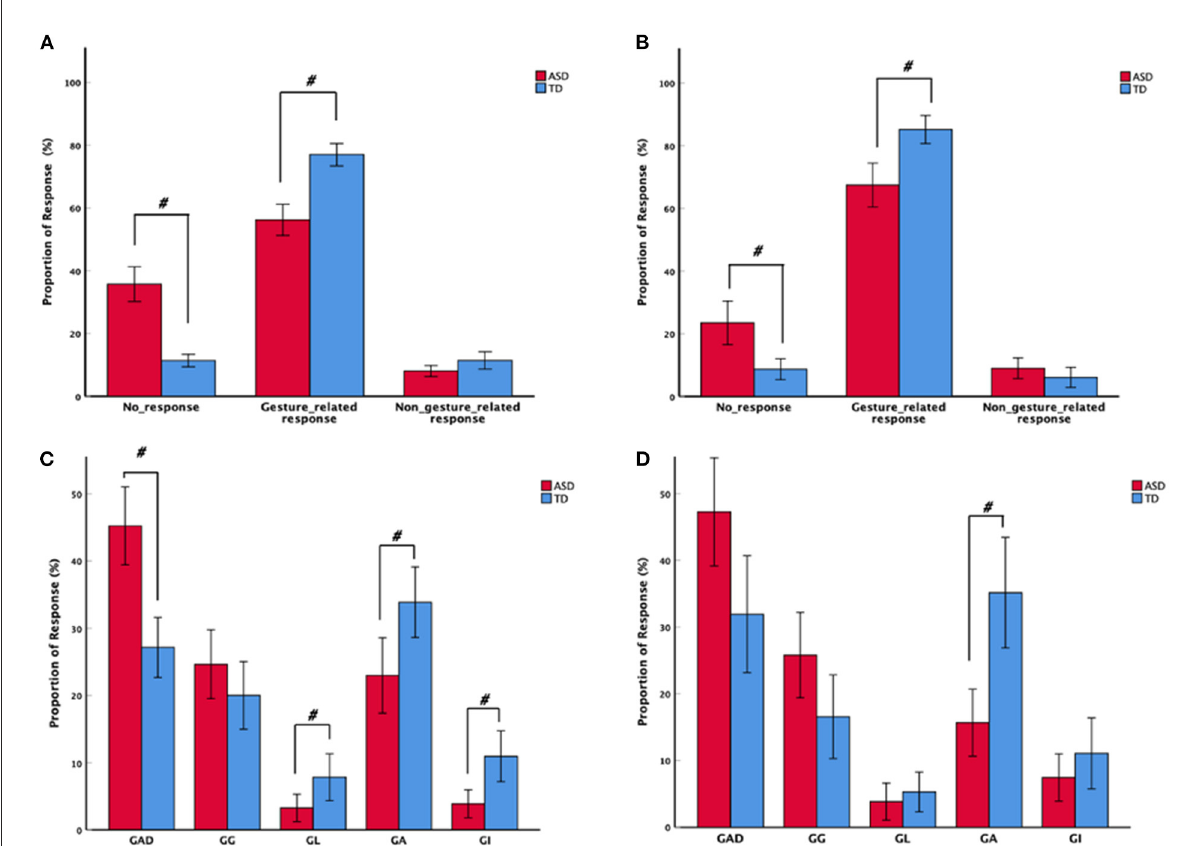
FIGURE3 Mean proportion of toddler response types to caregivers’ gestures among the autism spectrum disorder and typically developing groups in (A) play and (B) dining activities. Mean proportion of toddler gesture-related responses, including gesture-related attentional disengaging, gesture-related gestures, gesture-related actions, gesture-related language, and gesture-related integrative responses, to caregivers’ gestures in (C) play and (D) dining activities. With error bars showing ± 2 standard error. # Adjusted p <